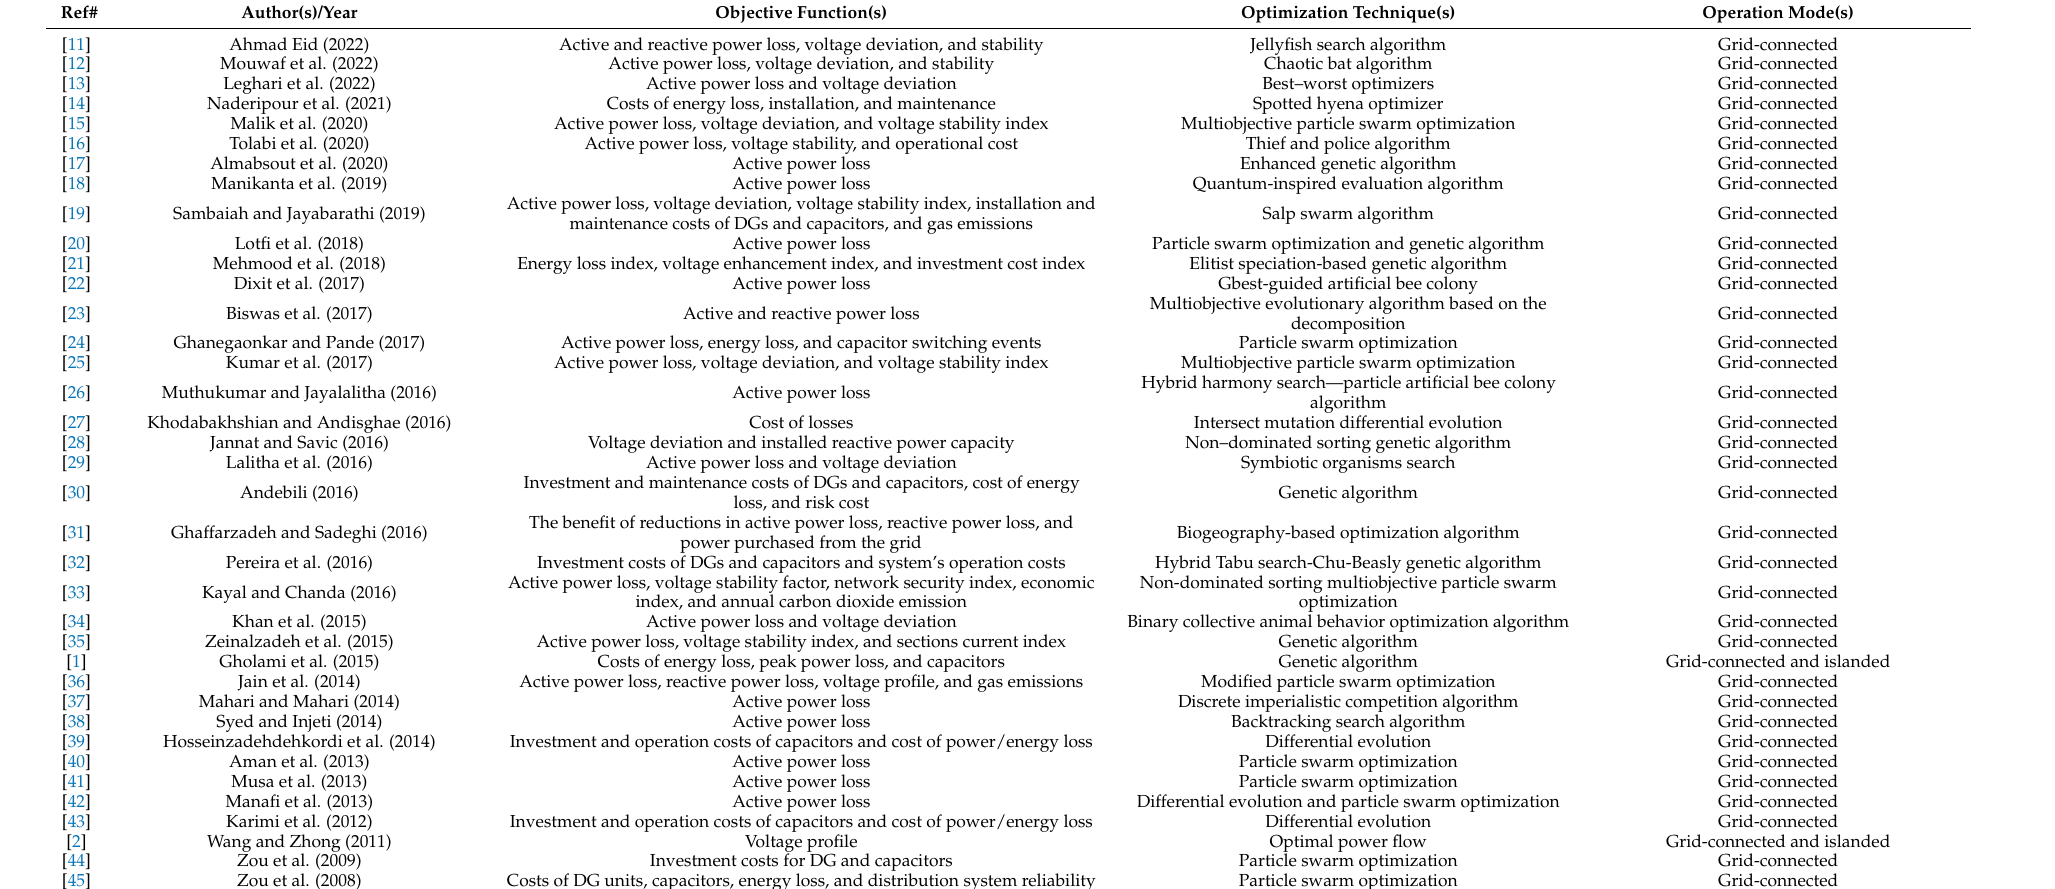
Table 1. A literature review summary on optimal DG and capacitor placements in distribution